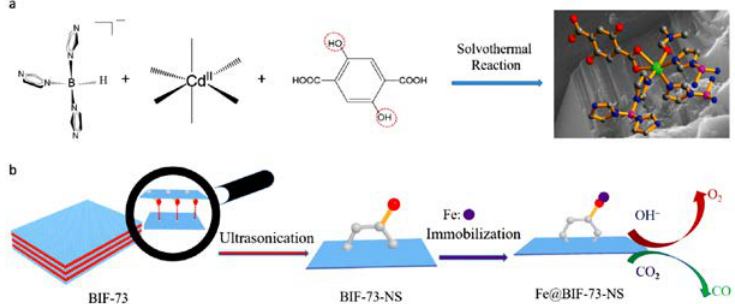
Figure 11. Schematic illustration of the BIF nanosheets for electrocatalytic application. ( a ) Scheme of the synthesis of BIF-73 (red circle: two potential functional OH groups, inset on the SEM of crystal: the coordination environment of BIF-73). ( b ) An ultrathin 2D BIF-73 nanosheets as the OER and CO 2 RR catalysis. The blue atom represents nitrogen, red atom represents oxygen, purple atom represents boron, grey atom represents carbon and green atom represents cadmium. Reprinted with permission from Reference 51.